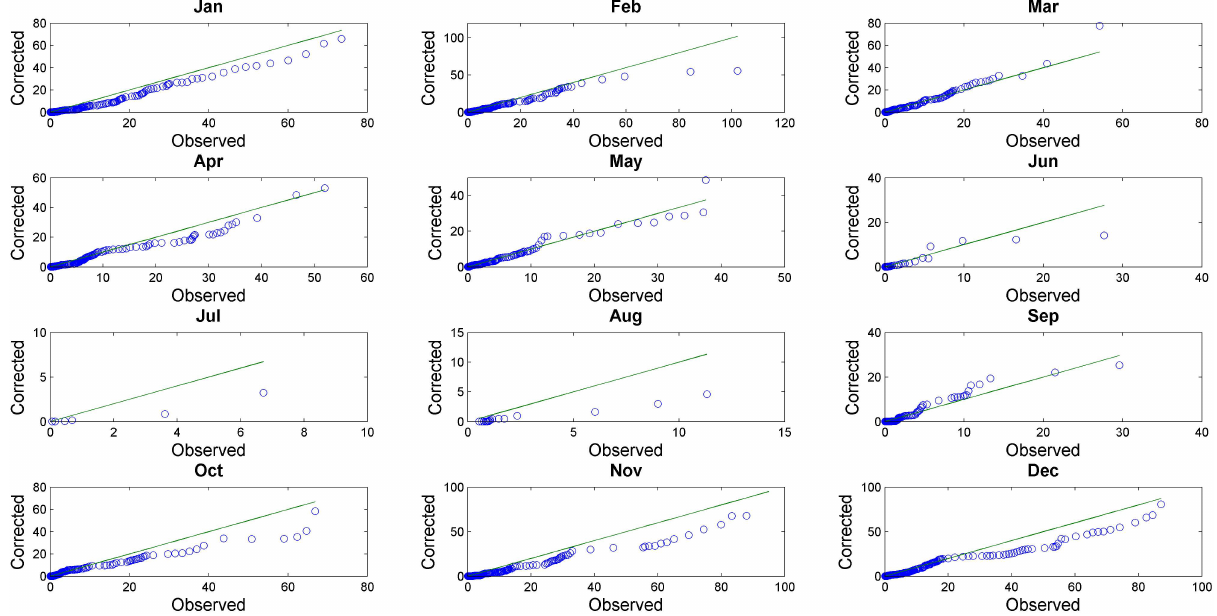
Fig. 11. Quantiles-quantiles plots between daily observed precipitation and bias-corrected precipitation from MED11-EVAL during the validation period 1998–2010.